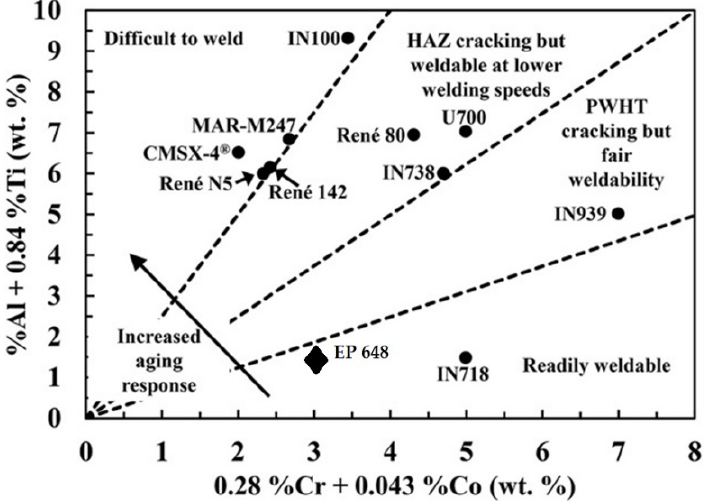
Figure 1. Weldability assessment for nickel-based superalloys (adapted with permission from Ref. [25], Copyright 2017, Wiley).